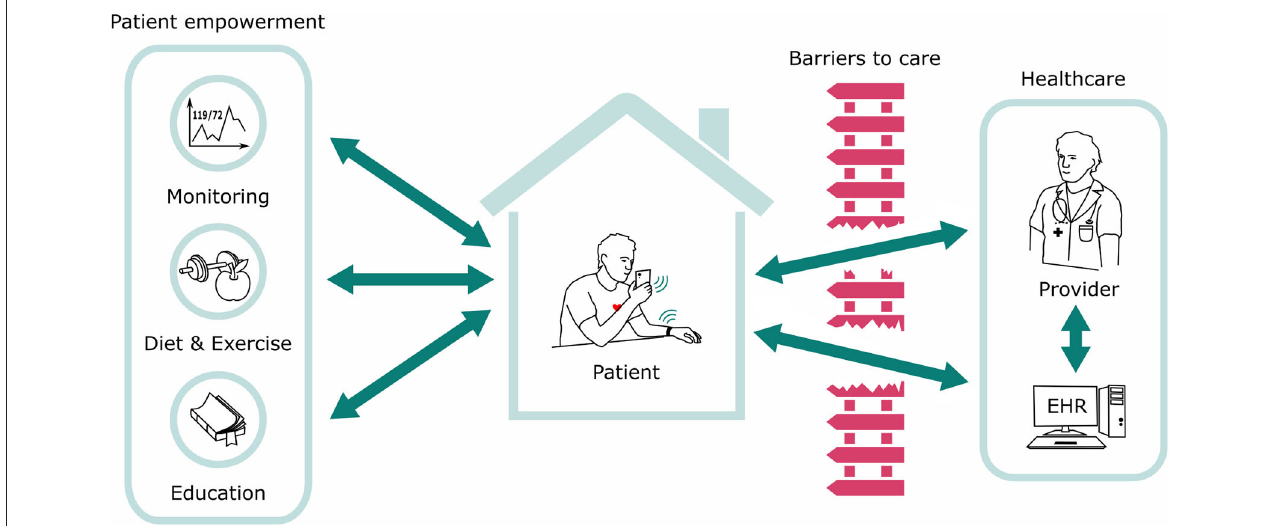
FIGURE 9 | The ecosystem of Digital Health Technology and the flow of information. Cuffless BP solutions are the natural next technological step in the evolution of the ecosystem.